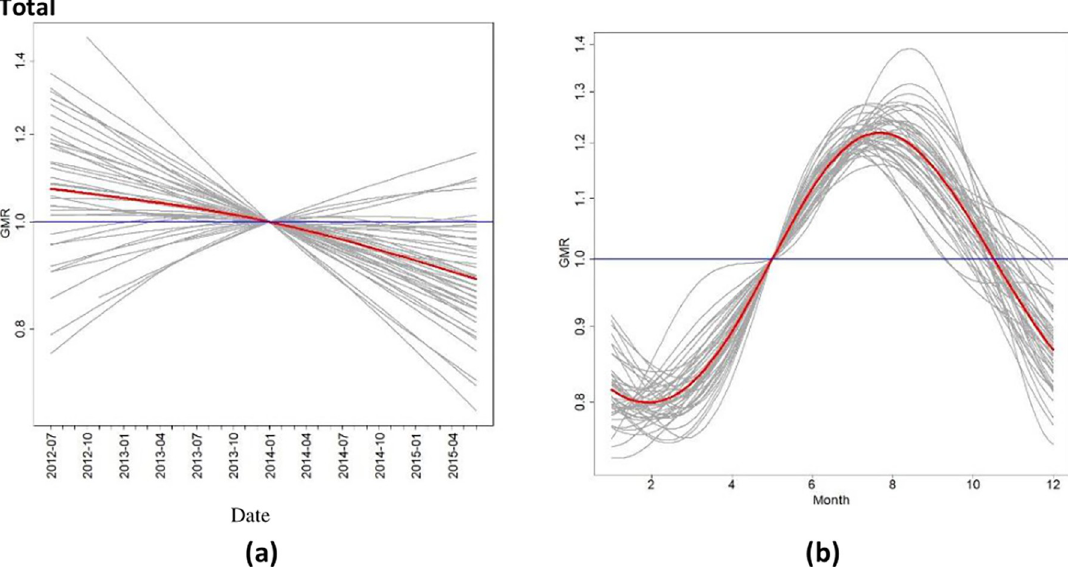
Fig 1. Results of the statistical model regarding the pre-intervention period (July 2012-June 2015). (a) Time trend over the months with y-axis displaying the geometric mean ratio (GMR) and x-axis the date (year and month). Time trends were modelled using natural regression splines. The GMR compares the geometric mean (GM) of topical AMU in each month to the average GM across the three- year period (GMR = 1 on January 2014 by definition). The grey lines depict the clinic-specific estimates, whereas the red line depicts the mean of the random effects distribution. Time trend is displayed for total topical AMU. (b) Seasonal pattern of total topical AMU. In the y-axis the GMR is displayed and on the x-axis the months. The seasonal effect was modelled using harmonic functions. The GMR compares the GM of topical AMU in each month to the average GM across the year (GMR = 1 on the month of May by definition). The grey lines depict the clinic-specific estimates, whereas the red line depicts the mean of the random effects distribution.